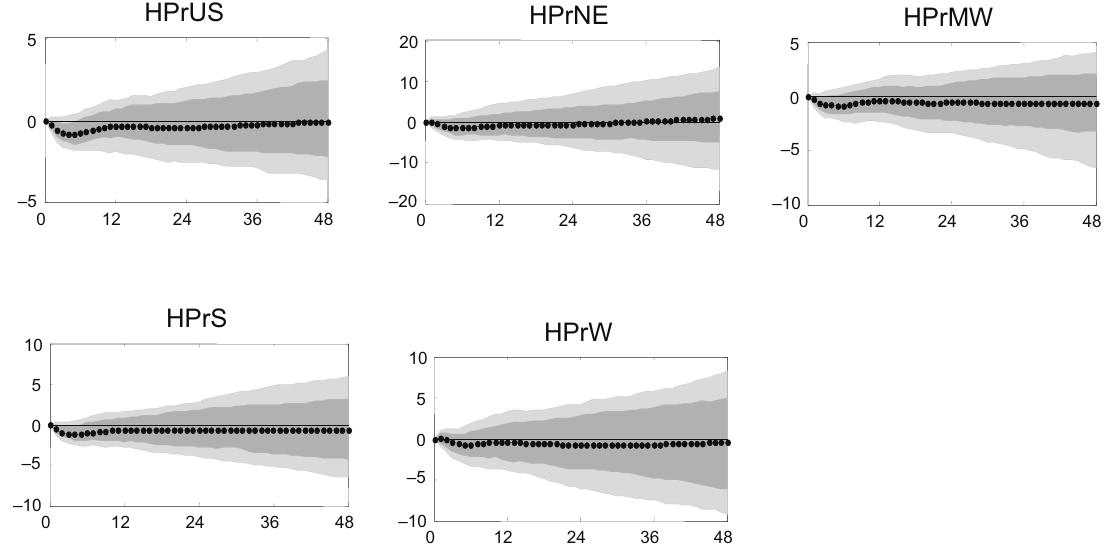
Figure 7. effect of 100-basis-point monetary policy shock on housing